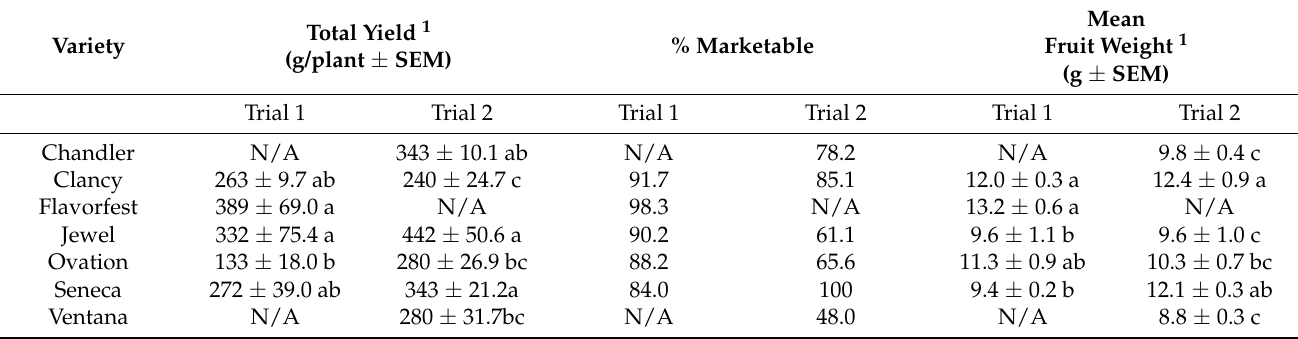
Table 2. Total yield per plant, % marketable yield and mean fruit weight for seven strawberry varieties grown in plasticulture in two trials in consecutive years. Percent marketable yield included fruit from dates when the mean fruit weight for the plots was 8 g or greater. ‘Flavorfest’ was only included in Trial 1 and ‘Chandler’ and ‘Ventana’ were only included in Trial 2.